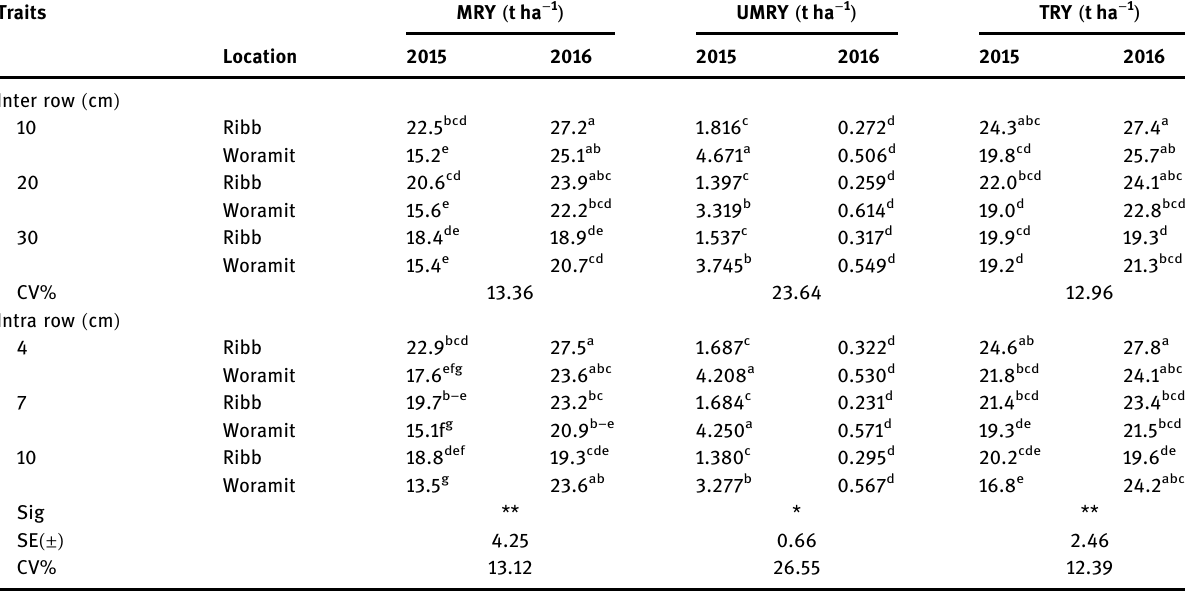
Table 6: Interaction e ff ects of spacing, locations, and season on the root yield of carrot